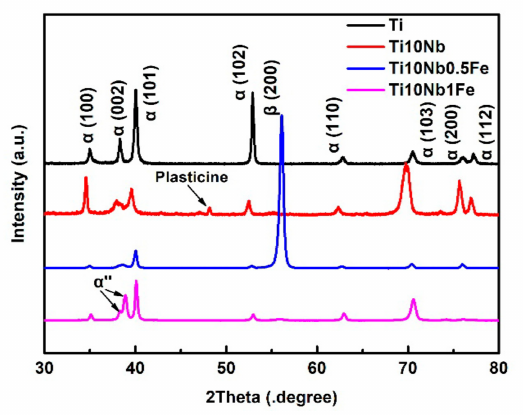
Figure 1. XRD patterns of pure Ti and Ti10NbxFe